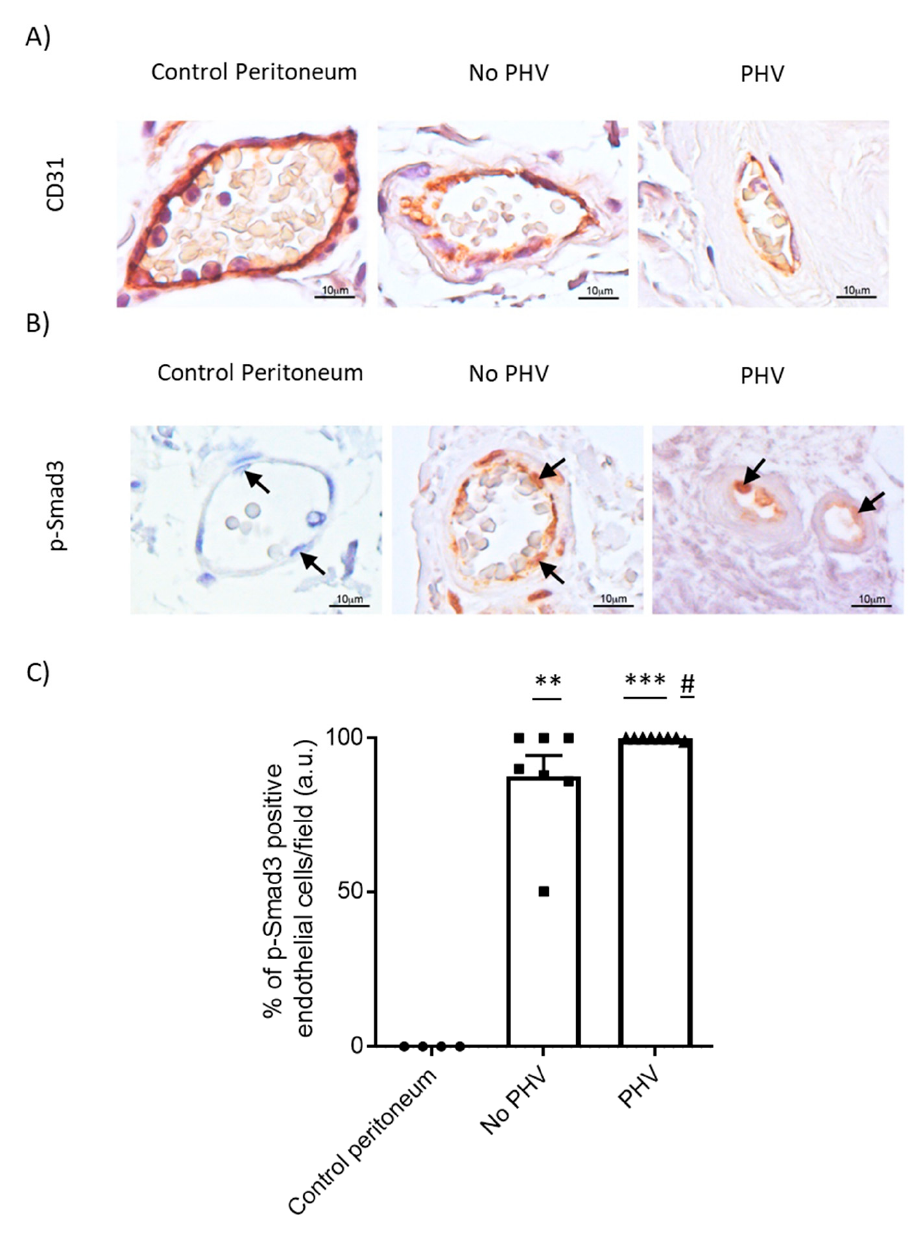
Figure 4. Immunohistochemical staining for CD31 and p-Smad3. ( A ) Endothelium of control peritoneal samples and PD-treated biopsies without PHV lesions present strong staining for CD31. On the contrary, endothelial cells of biopsies with PHV showed low intensity staining for CD31. ( B ) Endothelial cells from healthy biopsies were p-Smad3-negative. Nuclear p-Smad3 staining was found in the peritoneal endothelium of capillaries from PD-treated patients without and with PHV. Arrows point to endothelial cells. ( C ) pSmad3-positive endothelial nuclei were quantified and expressed as percentage of endothelial cells showing p-Smad3 positive staining per field. Bar graphic represents the mean ± SEM. ** p < 0.01 vs. control group; *** p < 0.005 vs. control group; # p < 0.05 vs. no PHV group.